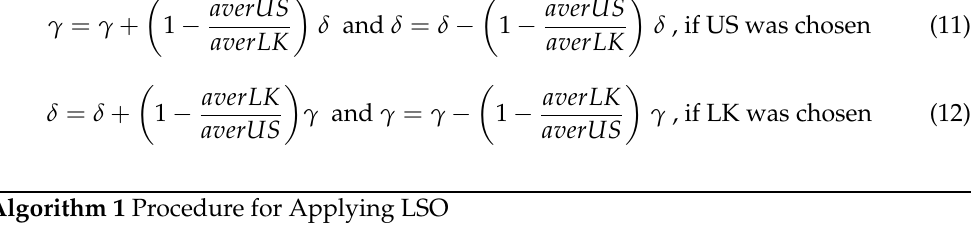
Algorithm 1 Procedure for Applying